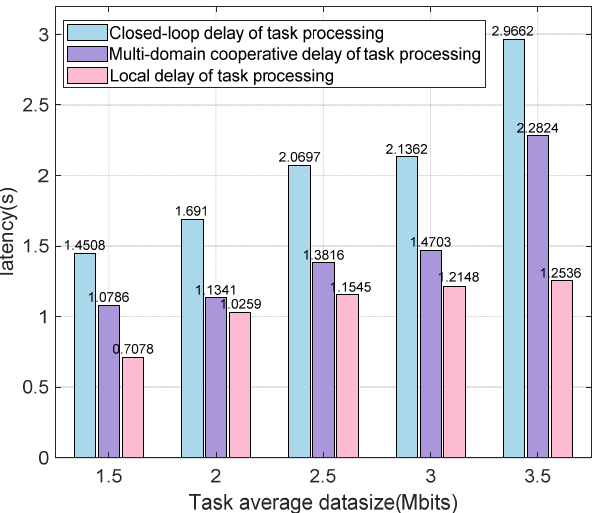
Figure 4. Variations in delay under various task processing stages for multiple task sizes.